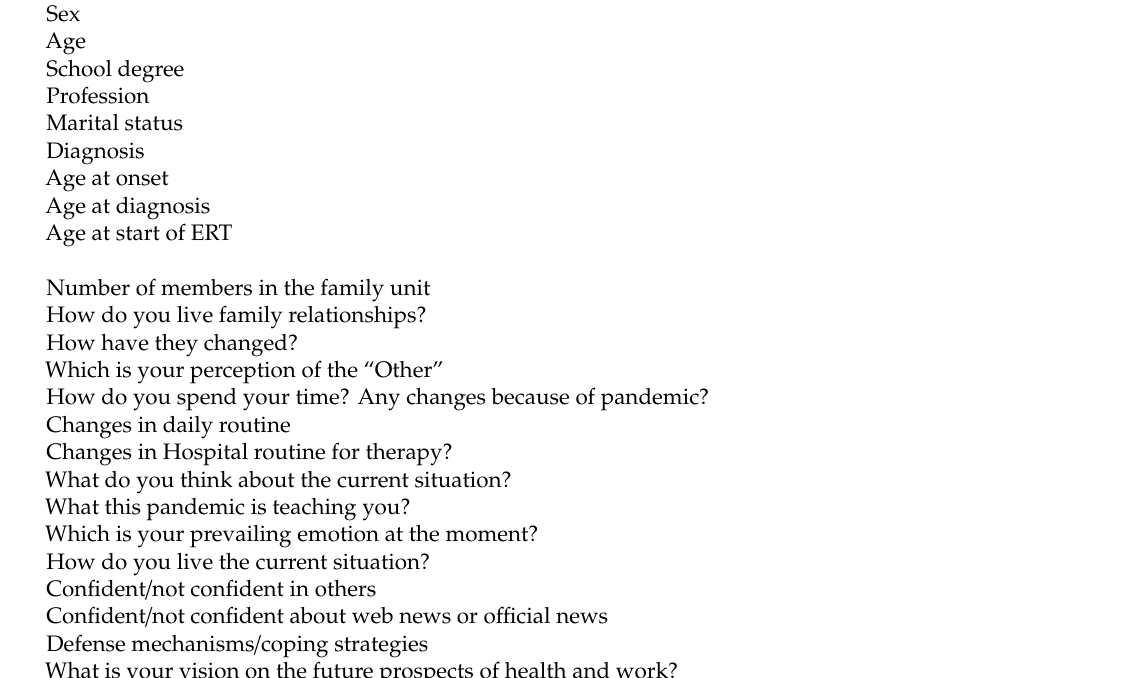
Table 1. Structured interview (topic